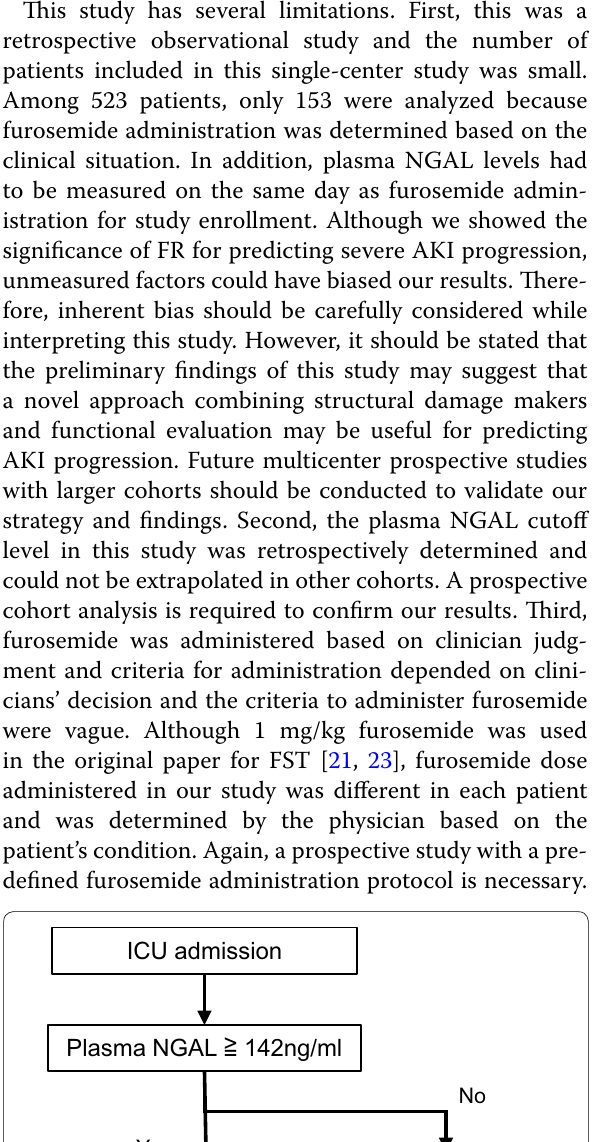
Fig. 5 Algorithm of plasma NGAL level and furosemide responsive- ness for AKI